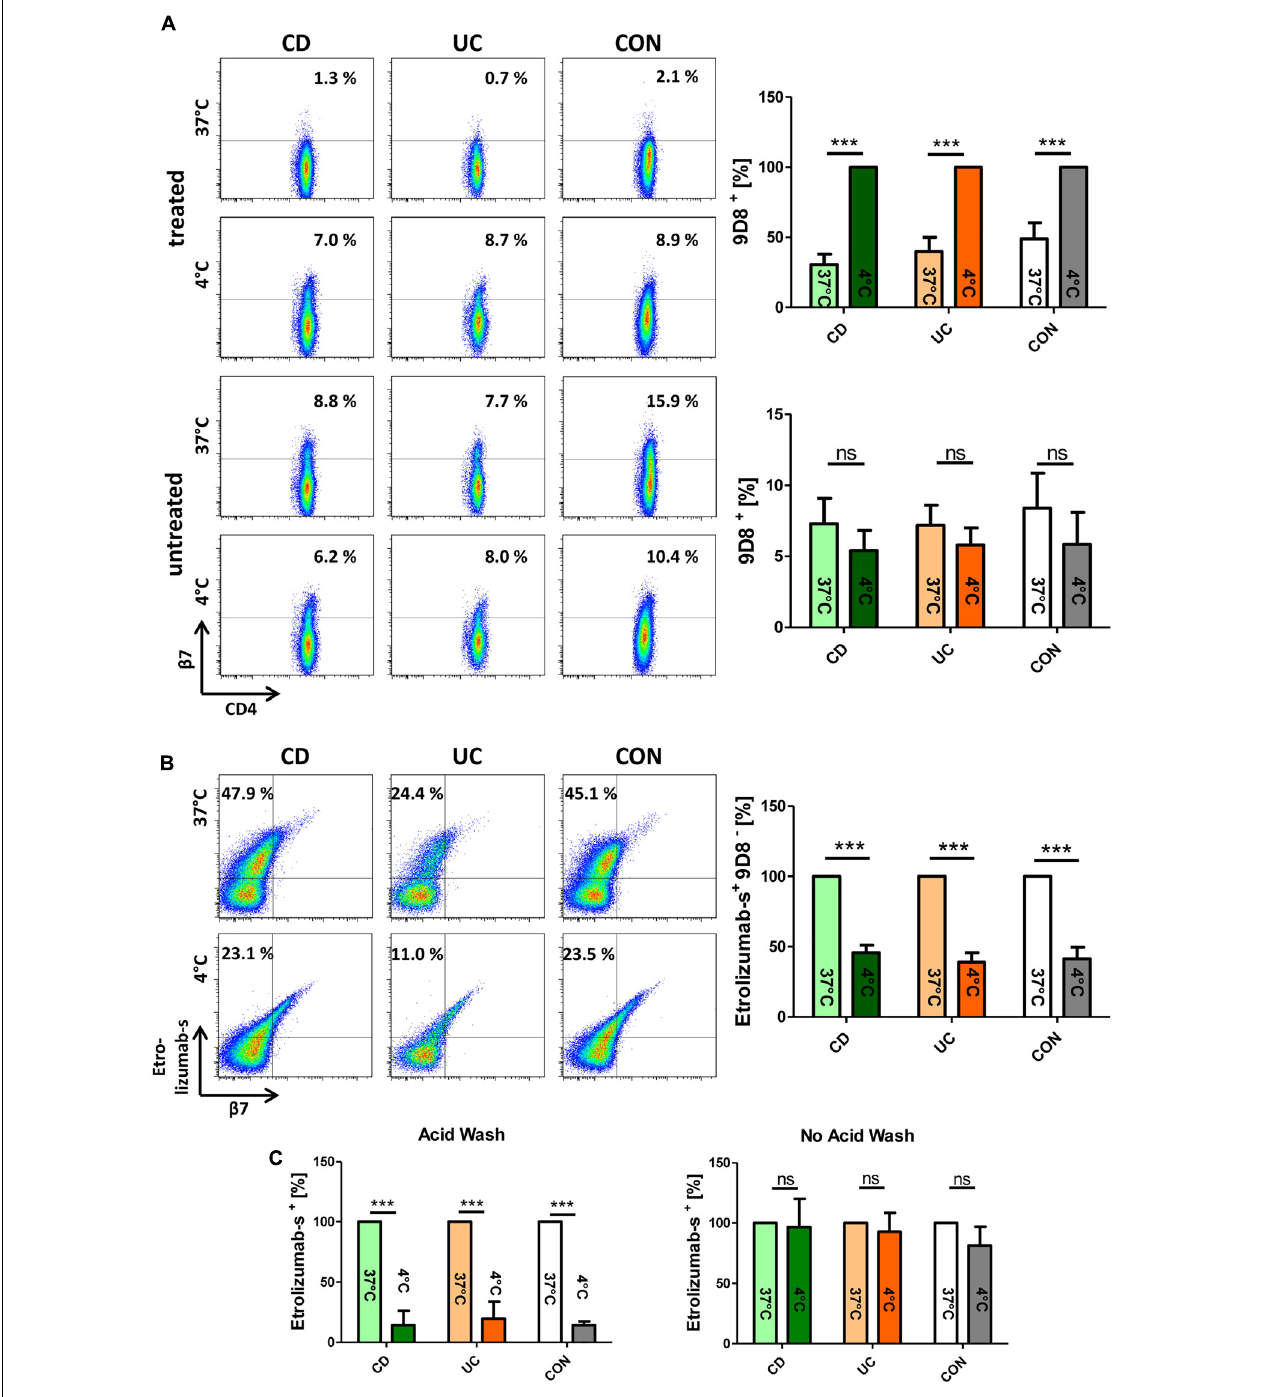
FIGURE 1 | β 7 integrin translocates from the cell surface to the inside of the cell upon in vitro treatment of lymphocytes with etrolizumab-s. (A) Upper panels: Flow cytometry of peripheral blood mononuclear cells (PBMCs) from patients with Crohn’s disease (CD), ulcerative colitis (UC), and control donors (CON) treated with etrolizumab-s for 24 h at 4 and 37 ◦ C. Left: Representative flow cytometry. The frequency of 9D8 + staining on CD4 + T cells is indicated. Right: Quantitative flow cytometry showing surface expression of 9D8 at 37 ◦ C relative to expression at 4 ◦ C ( n = 5 per group). Lower panels: Representative (left) and quantitative flow cytometry (right) of cells cultured at 4 and 37 ◦ C without etrolizumab-s treatment. (B) Flow cytometry of PBMCs from CD, UC, and CON donors treated with AF-647-labeled etrolizumab-s. Left: Representative flow cytometry. The frequency of etrolizumab-s + 9D8 − cells among CD4 + T cells is indicated. Right: Quantitative flow cytometry showing the proportion of these cells at 4 ◦ C in relation to 37 ◦ C ( n = 5 per group). (C) Quantitative flow cytometry of PBMCs treated with AF647-labeled etrolizumab-s at 4 or 37 ◦ C and subsequently subjected to acid wash (left) or not (right). n = 5 per group; data are normalized to expression at 37 ◦ C. ∗∗∗ p < 0.001; ns – not